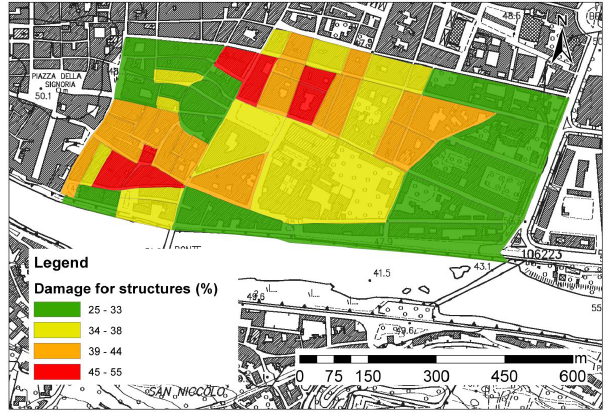
Figure 12. Monetary damage to the structures (€/m 2 ) for the 200 year flood. 2 Fig. 12. Monetary damage to the structures (Cm